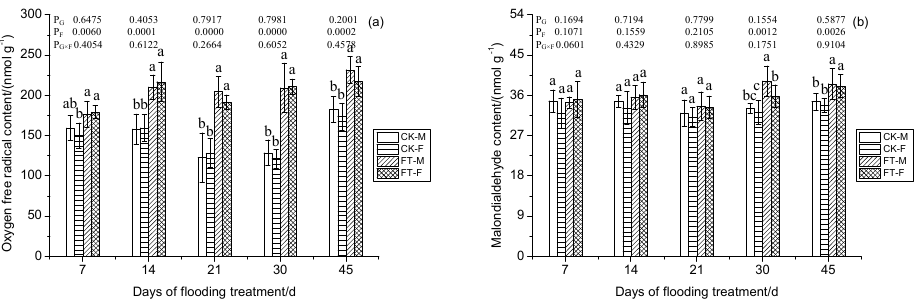
Figure 6. Production ratio of superoxide free radical (O 2 ∙ - ) (a) and malondialdehyde (MDA) (b) contents of male vs. female Salix viminalis plants at different times of flooding treatment.